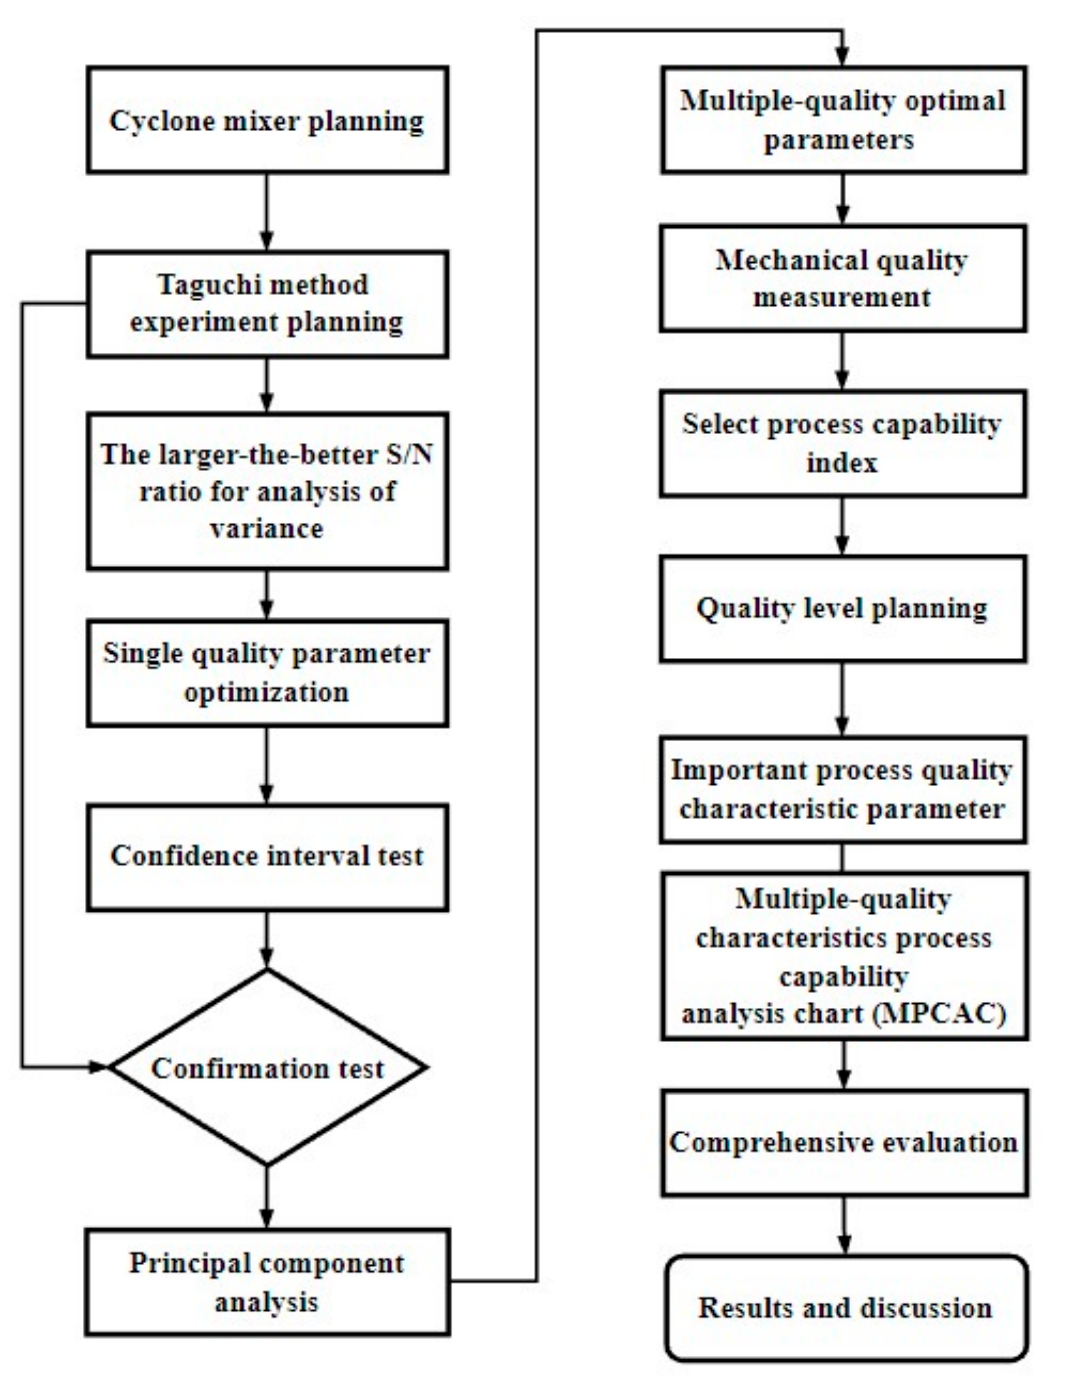
Figure 10. Research flow chart.